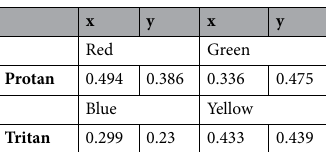
Table 2. End-point x, y coordinates defining the protan and tritan axis according to the CIE colour